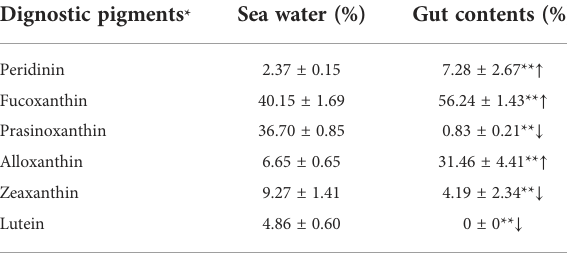
TABLE 3 Composition of the 7 detectable marker pigments in sea water and gut contents (n=3) in Experimental Group